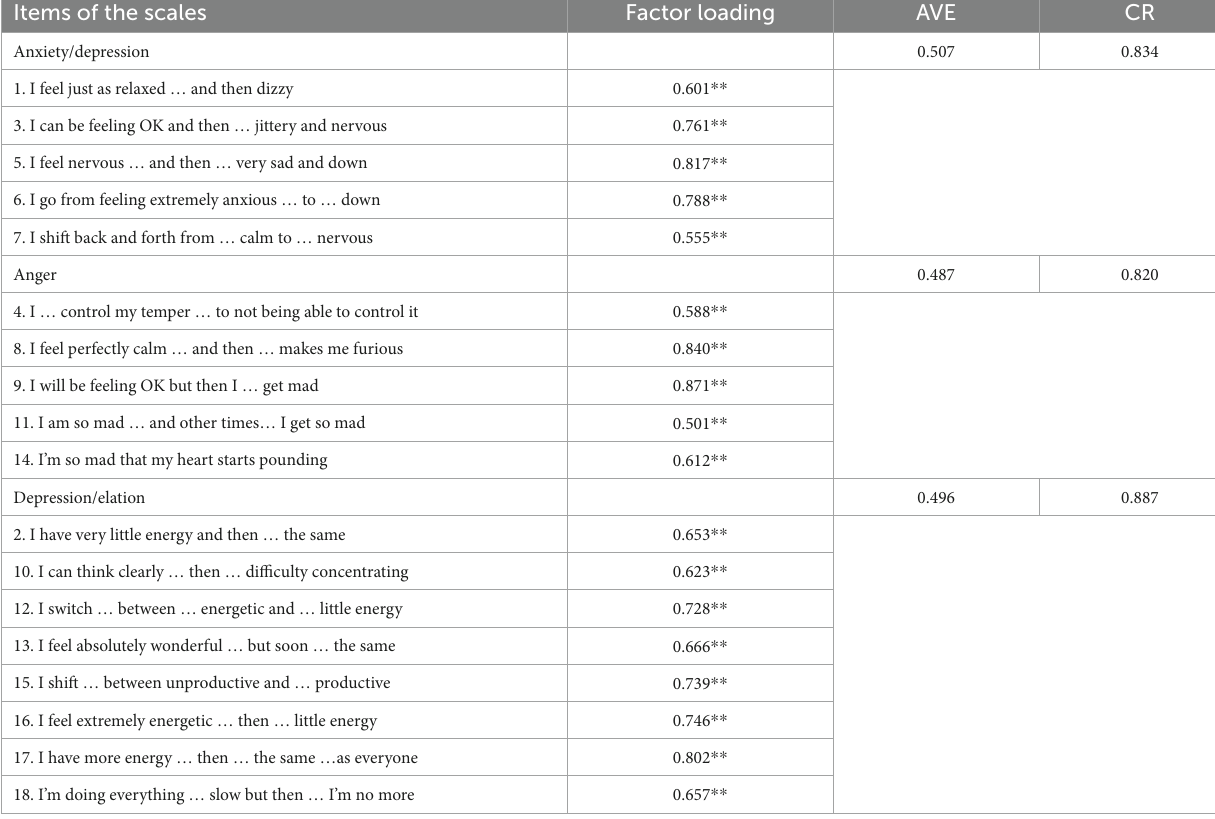
TABLE 2 Reliability and convergent validity for the Chinese version of ALS-SF ( n = 344). Items of the scales